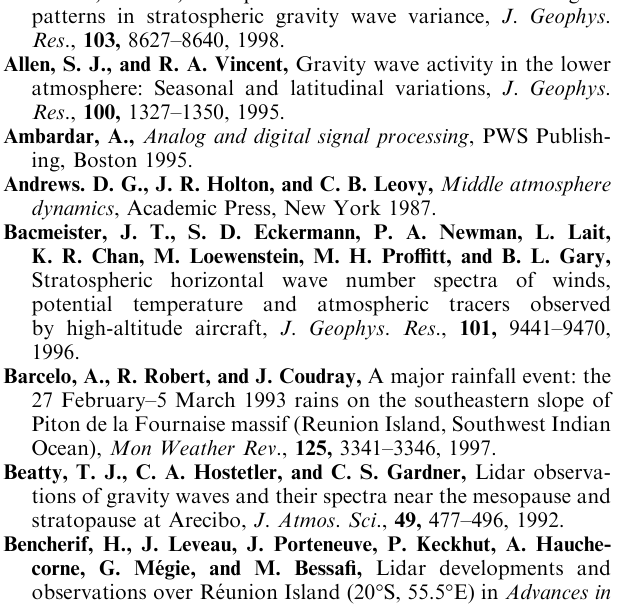
Table 3 gives the DB8 coe(cid:129)cients of the analysis FIR filters ( h ( n ) and g ( n )) used in this study.